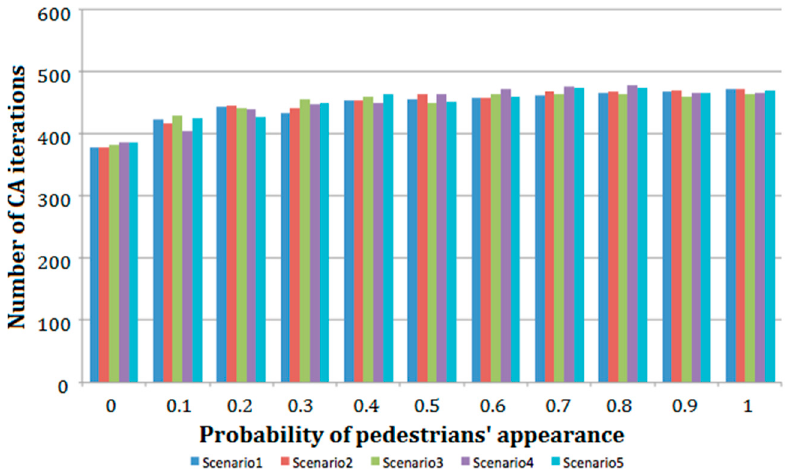
Figure 10. Impact of pedestrian traffic on roundabout capacity as per various traffic scenarios, distance between vehicles = 1. Specified speeds: max car speed = 5, truck speed = 2.